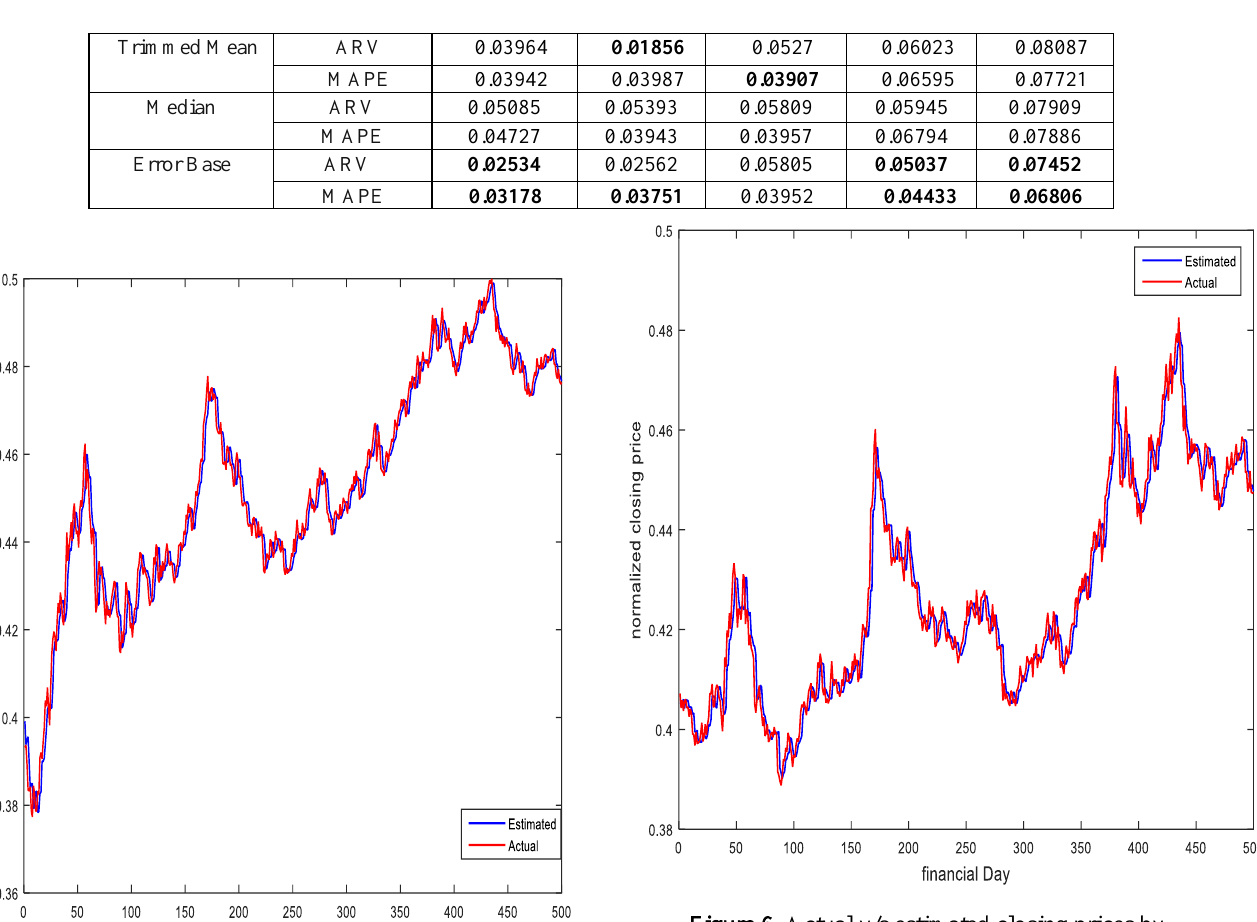
Figure 6 . Actual v/s estimated closing prices by combined method (error base) from